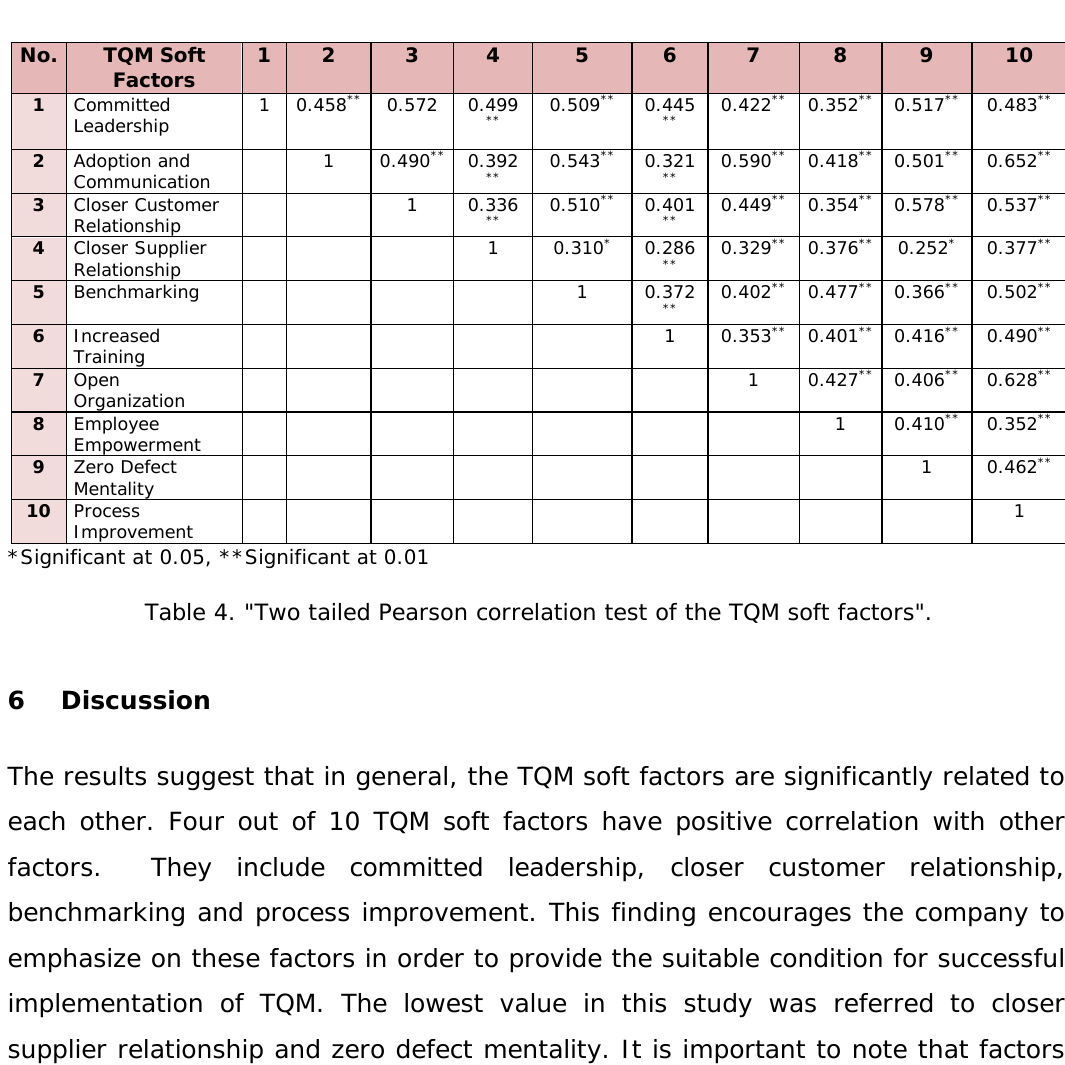
Table 3. "Mean and Std. deviation values of TQM soft factors".